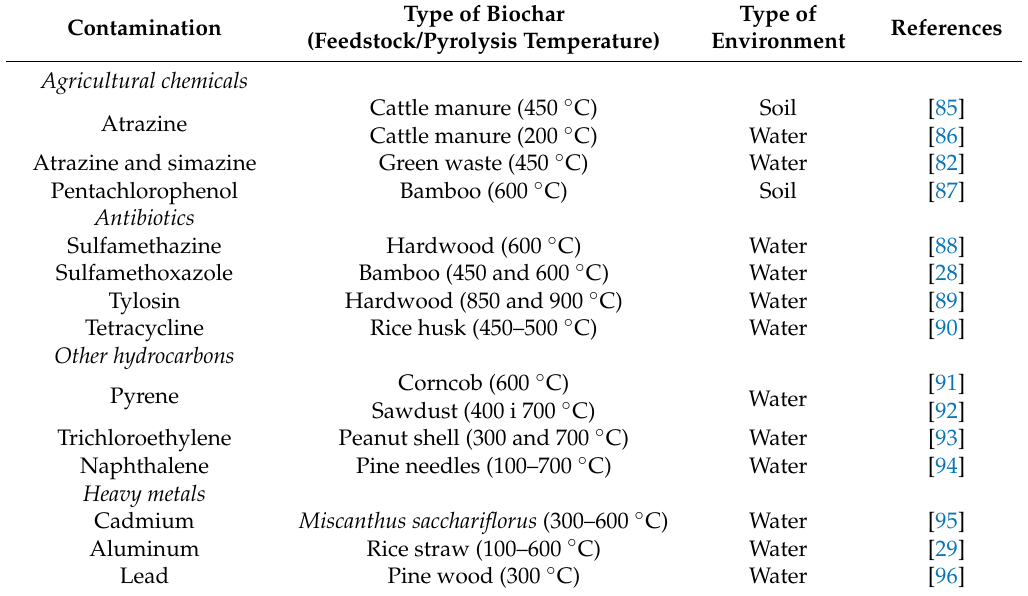
Table 5. Possible biochar applications for immobilizing contaminants in soil and